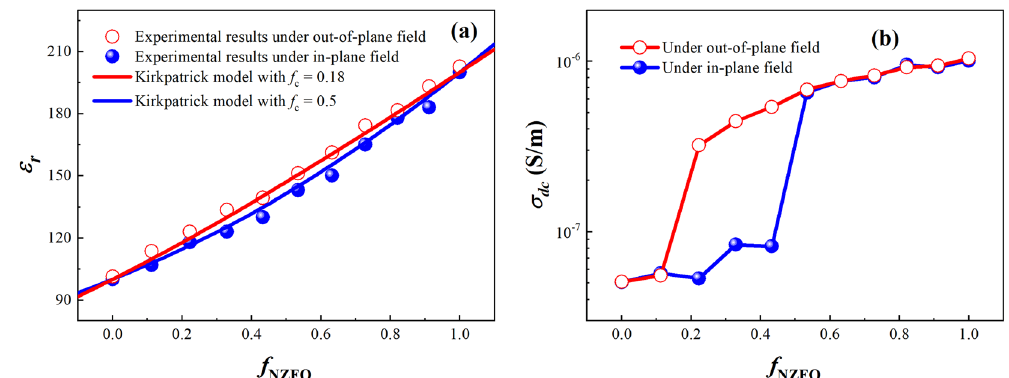
Figure 2. ( a ) Permittivity and ( b ) dc conductivity of the BTO-NZFO composite thin films under out-of-plane and in-plane electric fields as a function of f NZFO